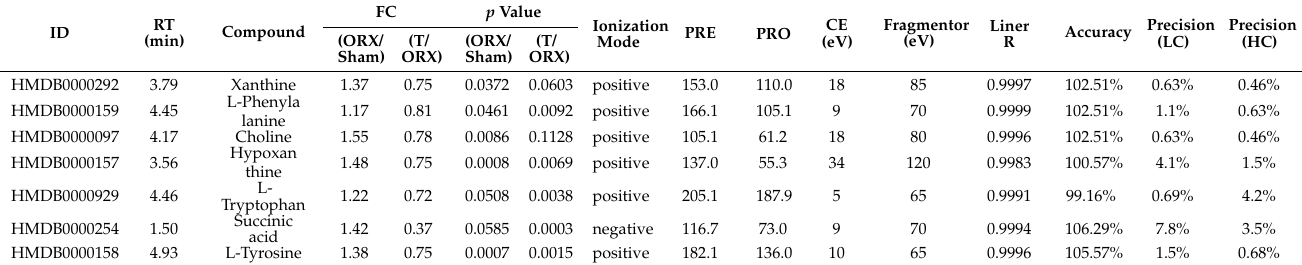
Table 2. MRM target metabolomics verification for seven metabolists.